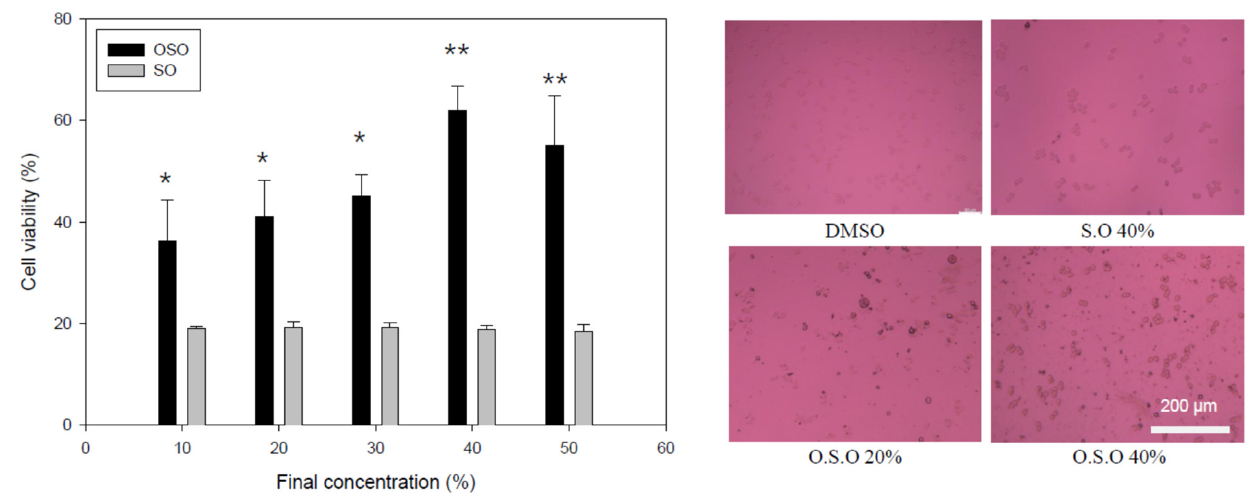
Figure 6. Cell viability and morphology of murine macrophage cells (Raw264.7) in the presence of ozonated sunflower oil. * p < 0.05 compared to SO; ** p < 0.01 compared with SO.